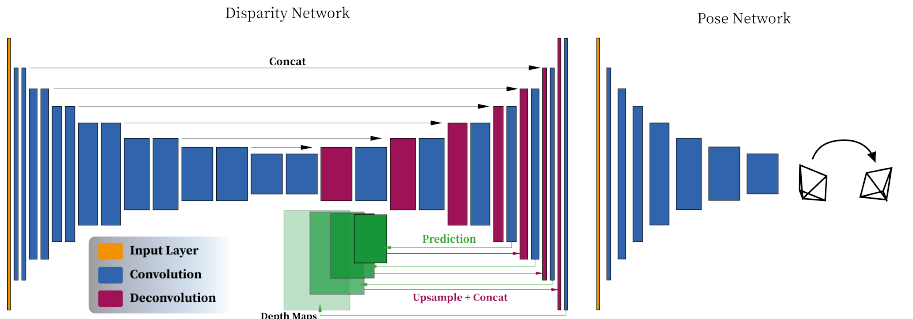
Figure 1. Illustration of the architecture of the Disparity estimation Network (DispNet) with the encoder–decoder layout and a pose estimation network. Additional details in terms of the size of each layer can be found in the original